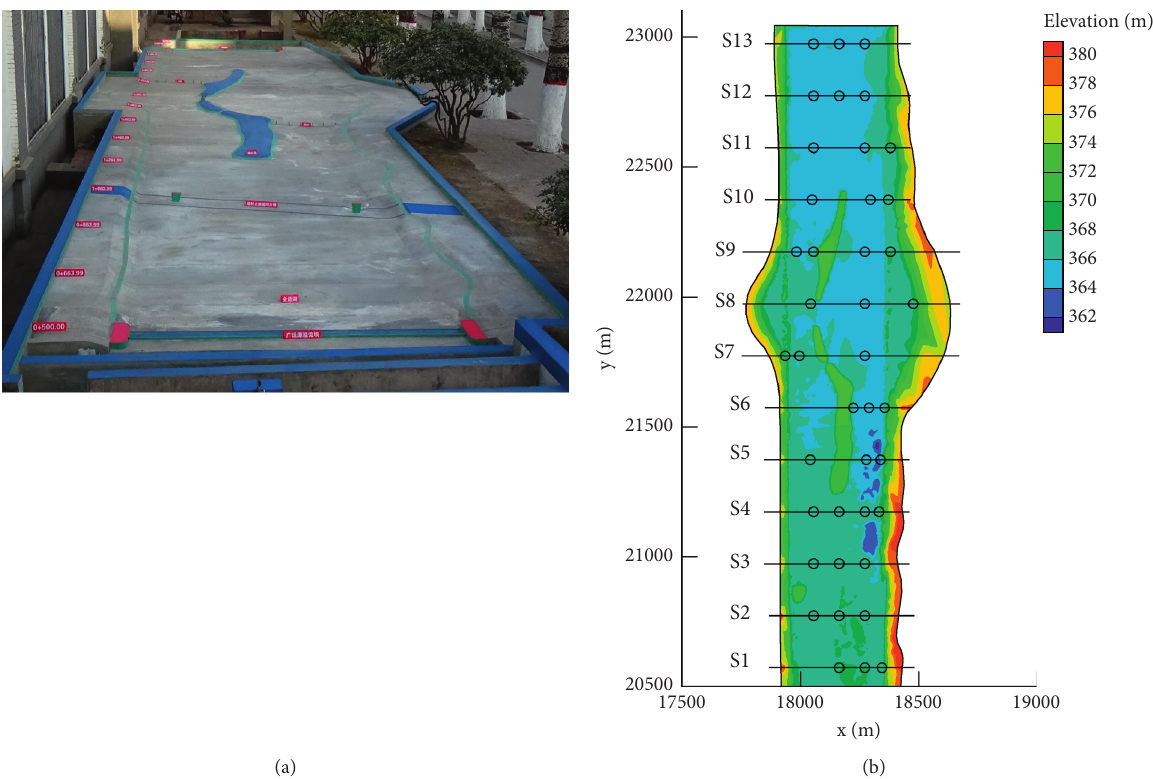
Figure 3: Physical model and measurement sections and points (circles: measurement points). (a) Picture of the physical model. (b) Measurement sections and points.